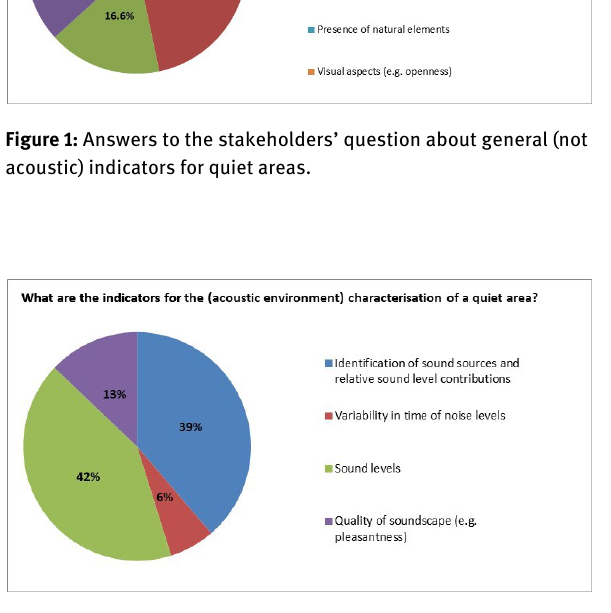
Figure 2: Answers to the stakeholders’ question about acoustic indicators for quiet